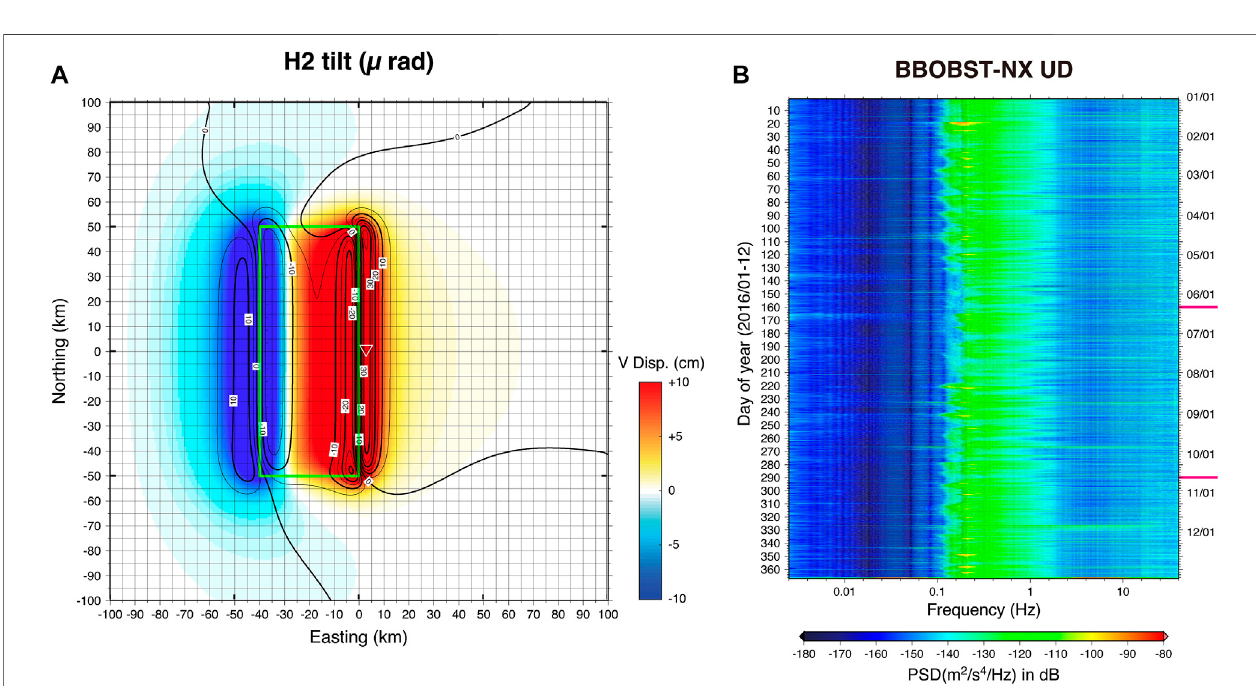
FIGURE 11 | A possible SSE for the large tilt change at the AoA40 site. (A) Similar result of Figure 10A , but for the assumed SSE based on Ito et al. (2013). The greenrectangleshowsthefaultplane(100 km × 40 km),andtheslipamountis1 m.Inthiscase,thepositionoftheBBOBST-NXisunknown.However,thecalculatedtilt range is between − 20 and +30 in µ radian. (B) The running spectrum of the vertical (UD) component is the same as in Figure 10B , but for the AoA40 site in 2016, including two starting points of the large tilt change at about June 10 and October 20, which are shown as two thick purple lines.